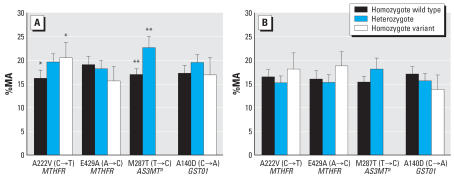
The mean and confidence interval of the %MA by genotype of MTHFR A222V, MTHFR E429A, GSTO1 A140D, and AS3MT M287T for (A) males and (B) females.aHeterozygotes and homozygotes for the varient allele in the AS3MT polymorphism are combined. *p = 0.01. **p < 0.001.